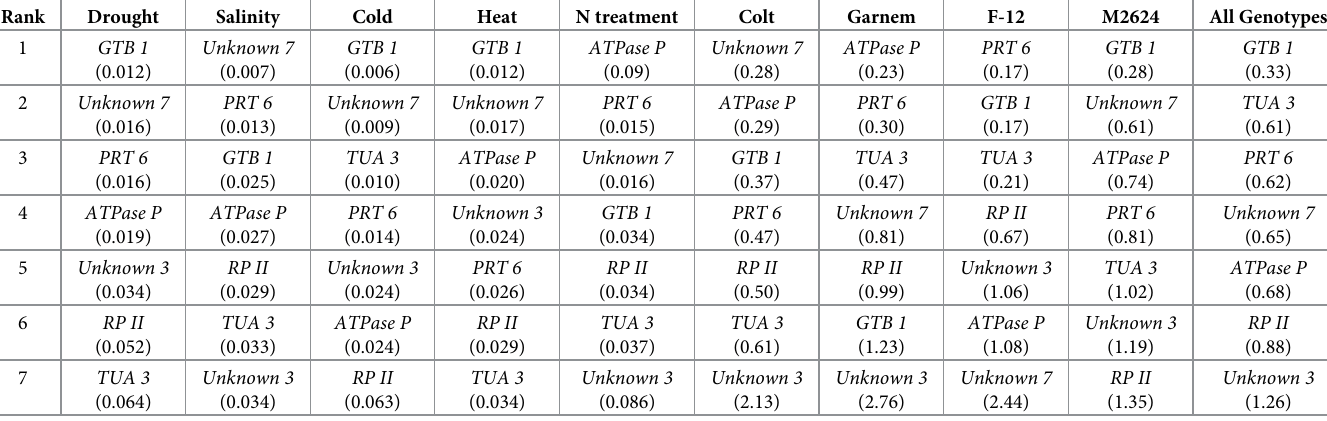
Table 4. Ranking of candidate protein-coding housekeeping genes calculated by NormFinder